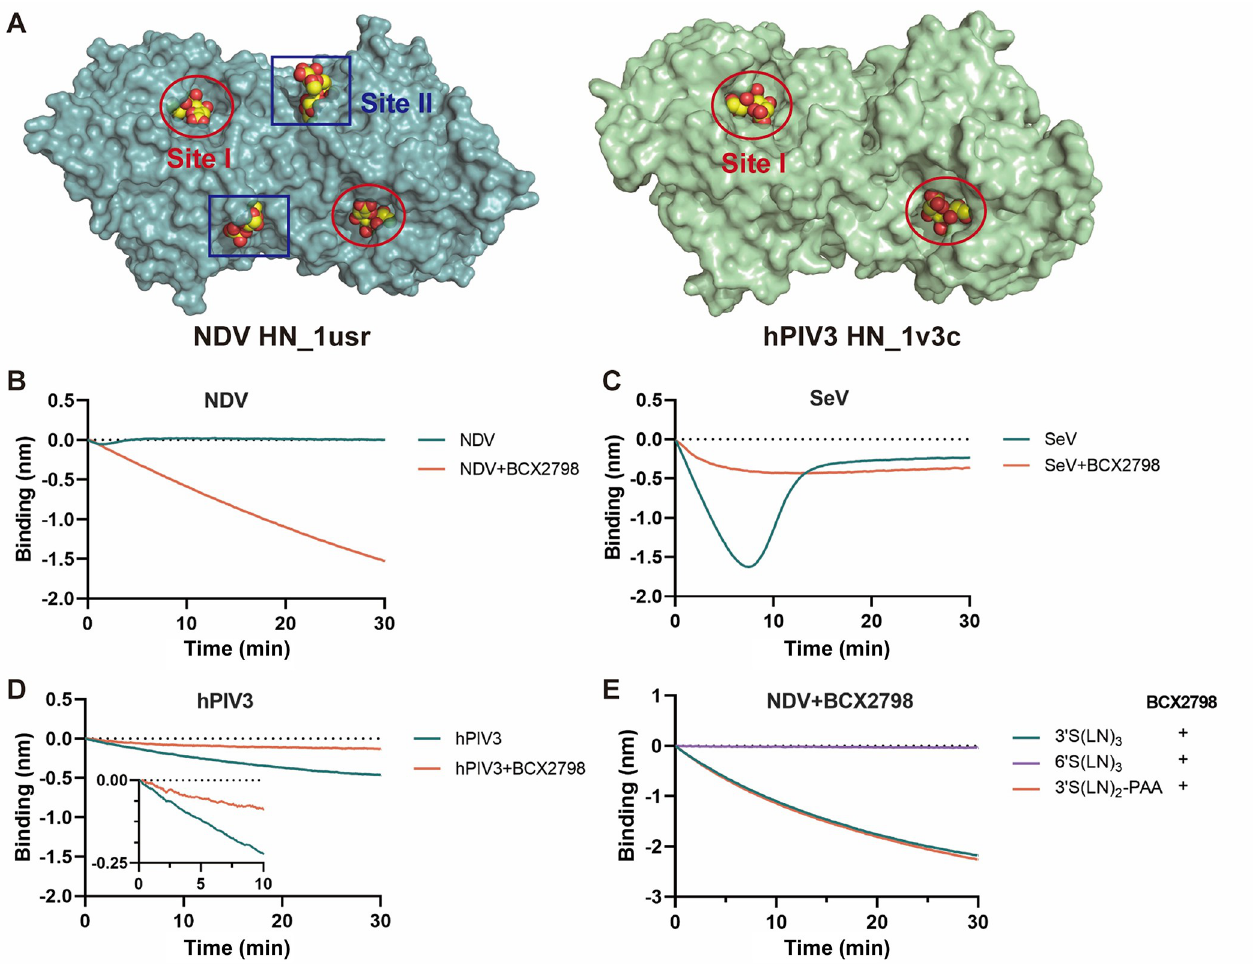
Fig 4. Interaction of NDV, hPIV3, and Sendai virus with 3’S(LN) 2 -PAA in the presence of BCX2798. (A) Structure of NDV (PDB 1usr) and hPIV3 (PDB 1v3c) HN dimer is shown in a surface representation. Catalytic site (Site I) and the 2SBS (Site II) occupied with Sia are indicated. Virus binding curves were generated similarly as described in the legend to Fig 2 using 3’S(LN) 2 -PAA for NDV( B ), hPIV3( C ), and SeV( D ) in the absence or presence of 1mM BCX2798. (E) Binding of NDV to 3’S(LN) 3 , 6’S(LN) 3 and 3’S(LN) 2 -PAA in the presence of